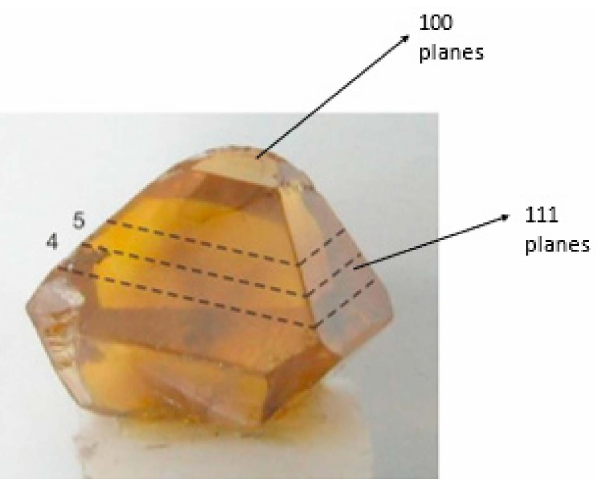
Figure 2. A yellow-brown diamond single crystal. The (100) and (111) crystallographic planes are shown. If plates are cut along dotted lines and polished, we obtain the (100) oriented plates which can be used as a substrate for CVD diamond growth. Further, the (110) crystallographic planes lie at 45 and 90 ◦ , respectively, to the (100) planes. The size of the crystal is about 4 mm × 4 mm. This image is taken from ref. [47]: Kazuchits, V.N.; Kazuchits, N.M.; Rusetskiy, M.S.; Korolik, O.V.;